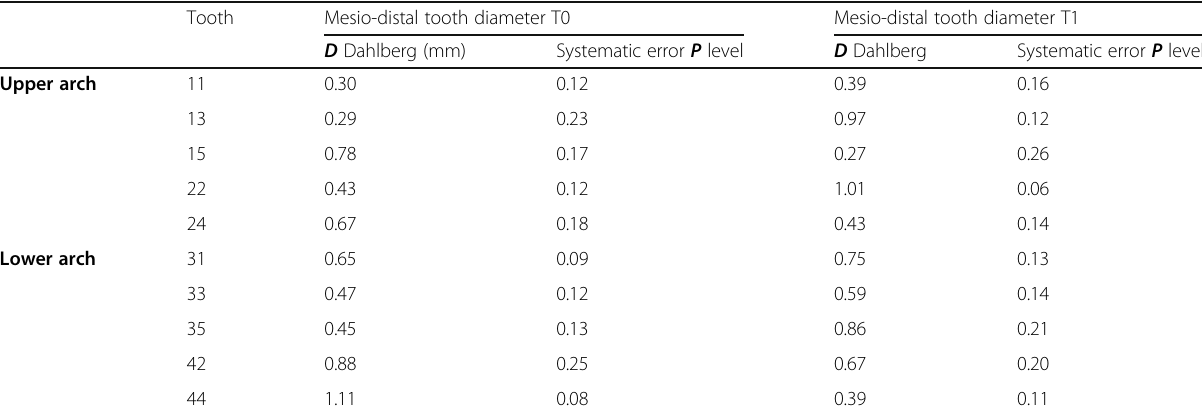
Table 1 Error analysis